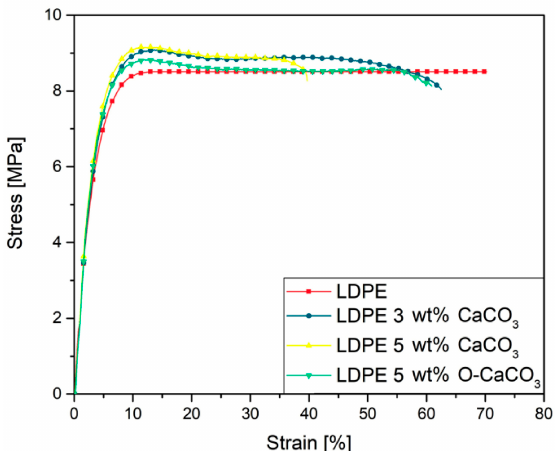
Figure 4. Stress-strain curves for neat LDPE, LDPE/CaCO 3 with 3 and 5 wt%, and LDPE/O-CaCO 3 with 5 wt% nanocomposites.